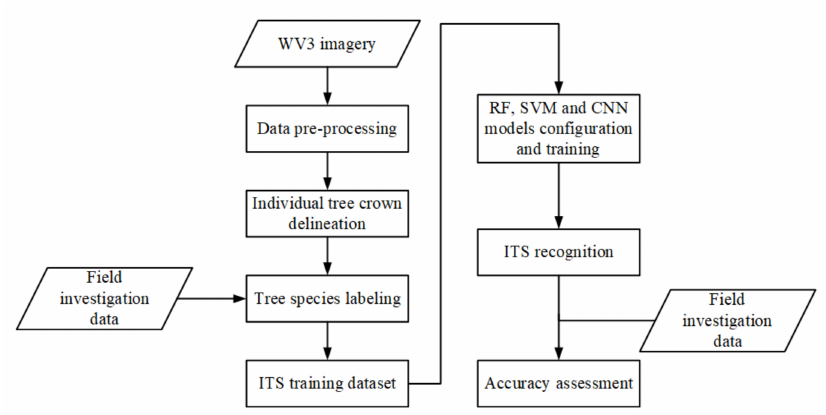
Figure 4. The technical flowchart of the convolutional neural network (CNN)-based multi-scale individual tree species (ITS) recognition (CMSIR) method. RF, random forest; SVM, support vec- tor